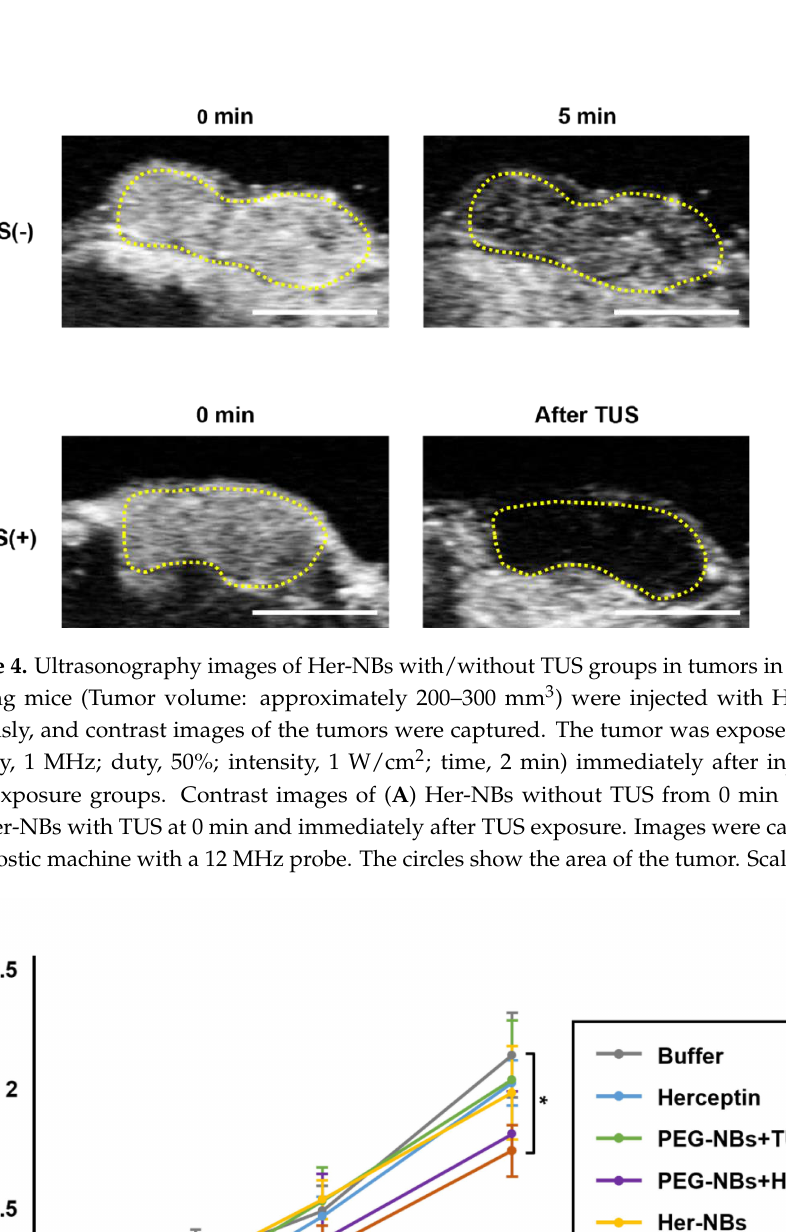
8 of 14 Figure 3. Activity of Herceptin on Her-NBs before/after TUS exposure. To evaluate the activity of Herceptin, luminescence intensity of Jurkat effector cells, expressing NFAT-RE-luc2, was measured by ADCC reporter bioassay against SKOV3 (T). SKOV3 cells were plated in a 96-well plate the before assay. On the day of assay, samples and effector cells (E) were added to the plate (cell rate; E: T = 15: 1). After 6 h of incubation at 37 °C/5% CO 2 condition, Bio-Glo TM luciferase assay regent was added, and the luminescence intensity was determined using luminometer. ( A ) Luminescence intensity of Herceptin in Her-NBs after TUS in serial concentration of lipid. ( B ) Comparison of luminescence intensity of Her-NBs before and after TUS exposure in 2.5 µg of lipid. ( C ) Calculation of titer of Herceptin in Her-NBs using the standard curve of the amount of Herceptin versus luminescence intensity. Data = mean ± SD ( n = 4). The unpaired t -test was used for statistical analysis. 3.3. Evaluation of Responsive of Her-NBs to Therapeutic Ultrasound In Vivo